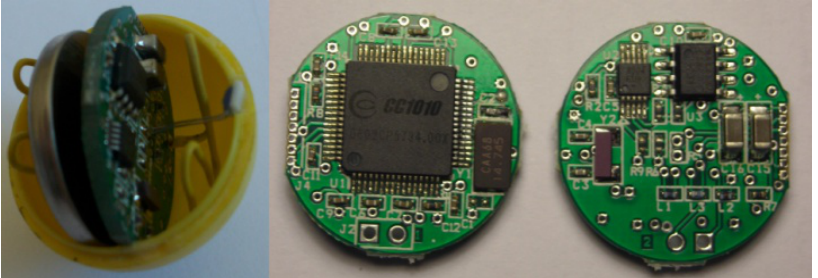
Figure 2. Autonomous sensor inside the POM sphere (left) and detail of the electronic circuitry